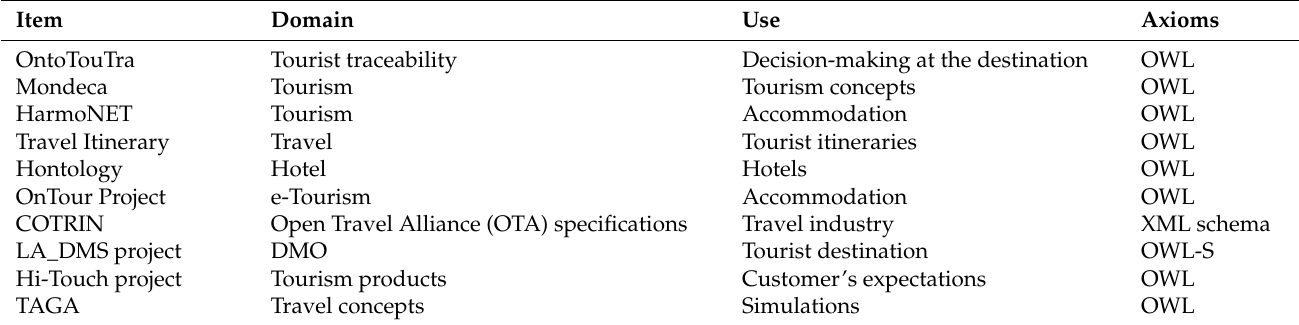
Table 13. OntoTouTra vs. other tourism